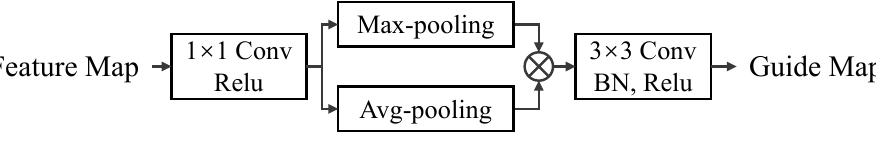
Figure 5. Structure of the guide